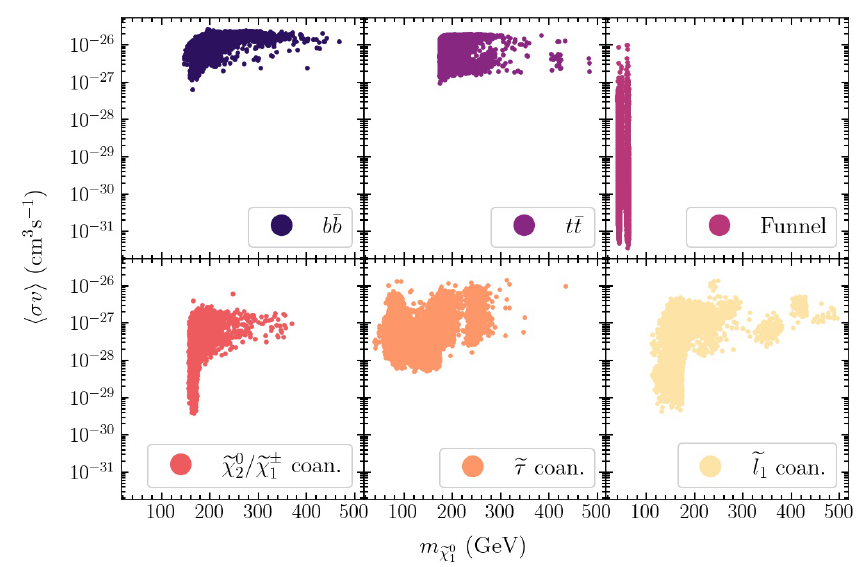
) vs the velocity-weighted annihilation χ 0 (cid:101) 1